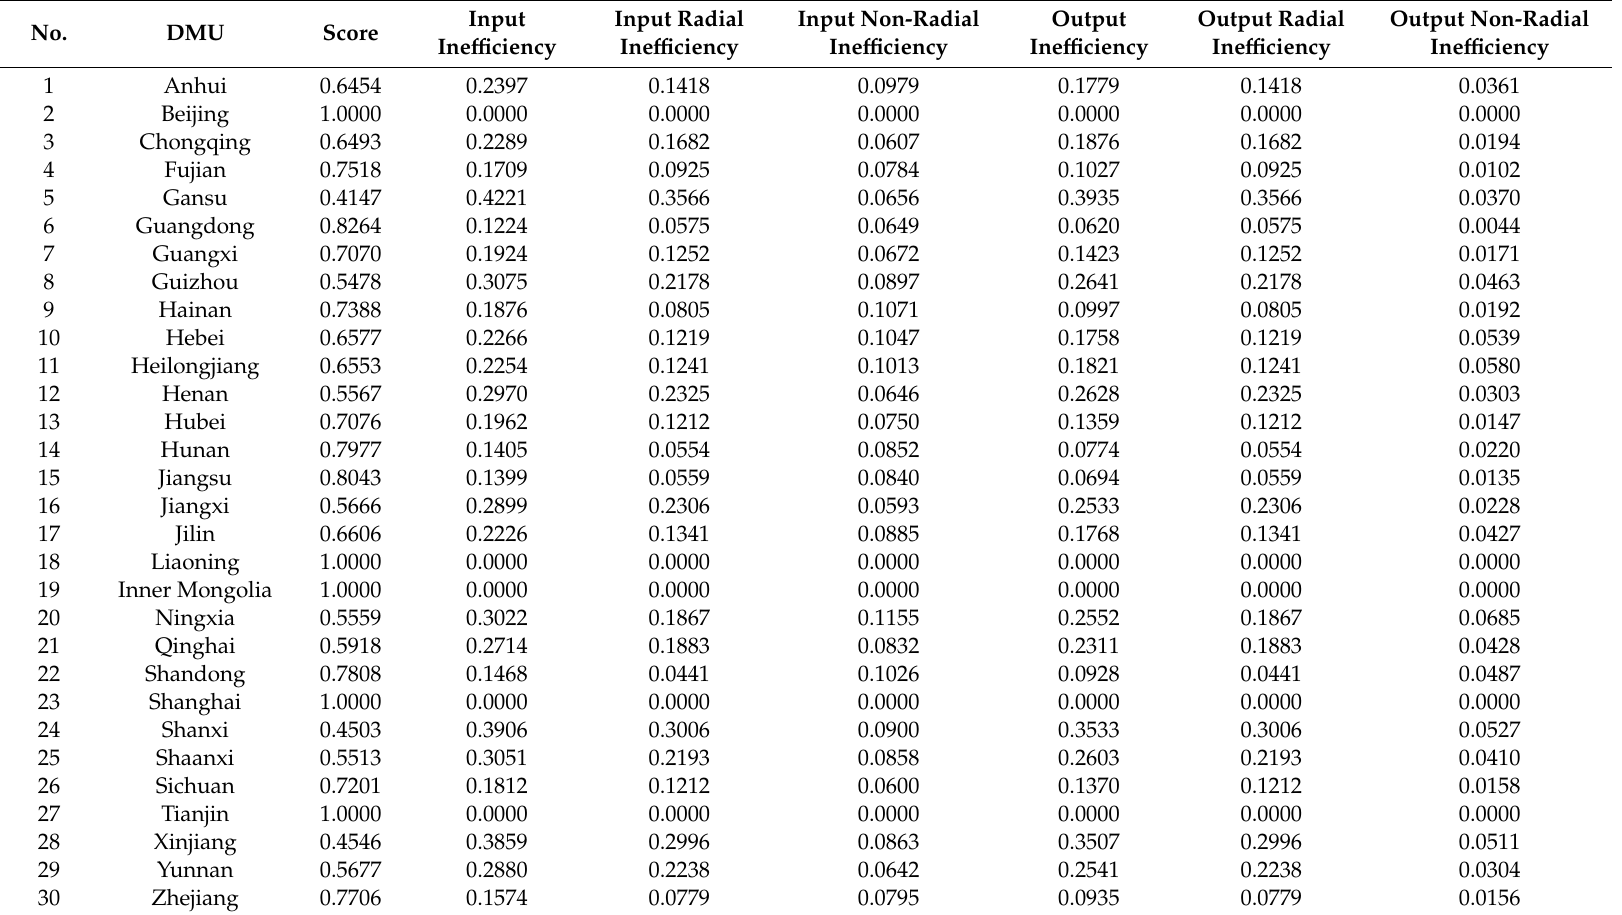
Table 7. 2016 input and output indicator radial and non-radial ine ffi ciency